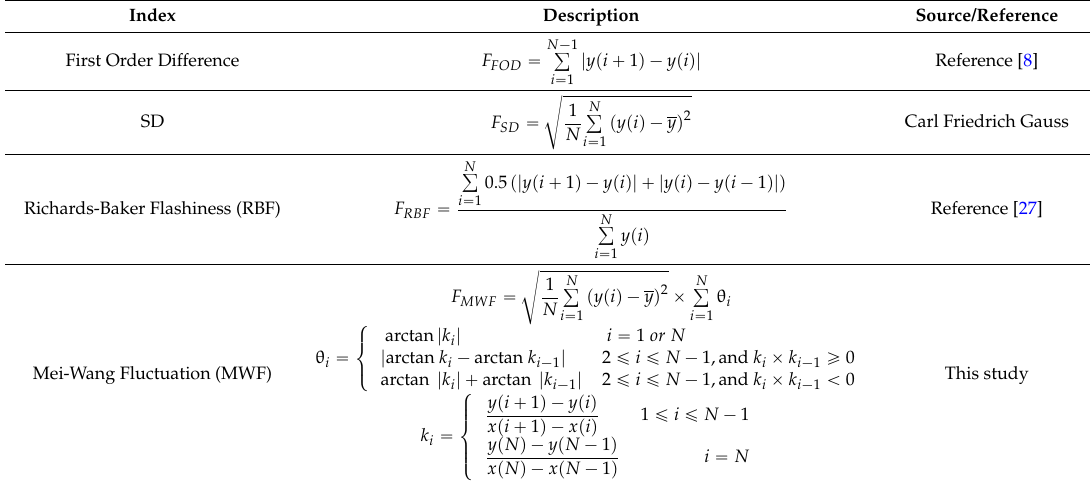
Table 1. Indices used to characterize the fluctuation of processes.